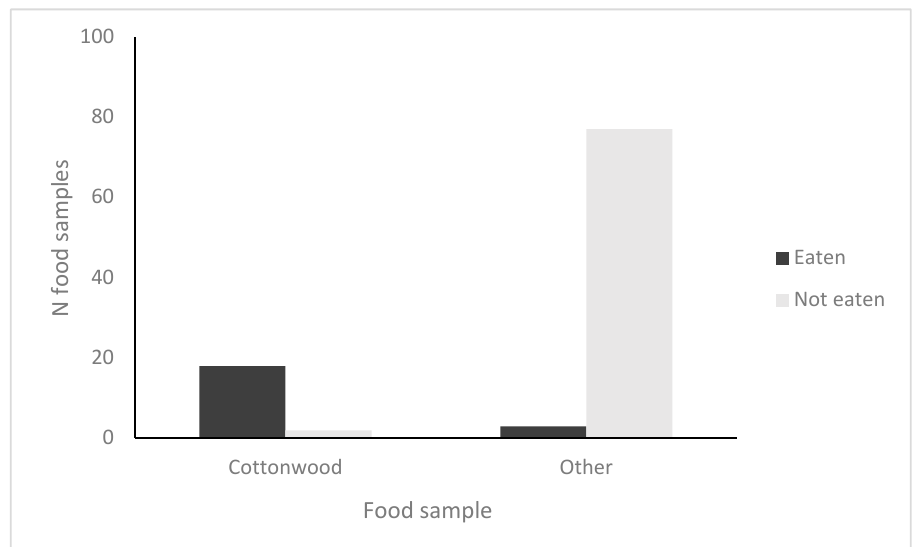
Figure 2. Results of foraging preferences for beavers at Dry Beaver Creek, AZ in four trials of 25 (100 total samples). Beavers ate 18/20 (90%) of cottonwood samples and 3/80 (4%) of non-cottonwood samples; the data collapsed into a 2 × 2 table for analysis were significant ( G = 64.2, df = 1, p < 0.0001).